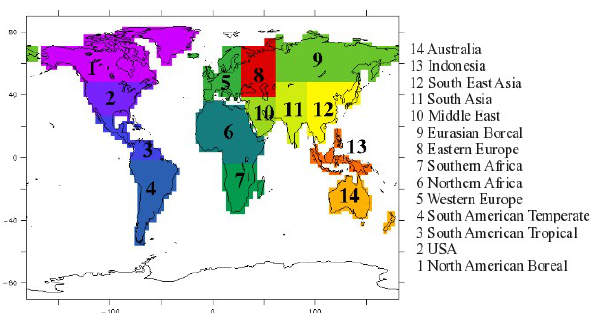
Figure 3 . Definition of the14 regions used in this study. 1014 Fig. 3. Definition of the 14 regions used in this study.